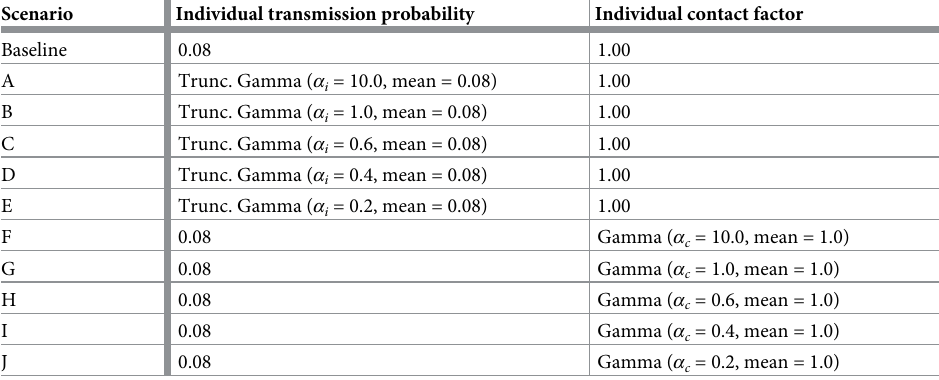
Table 1. Overview of scenarios. Scenario Individual transmission probability Individual contact